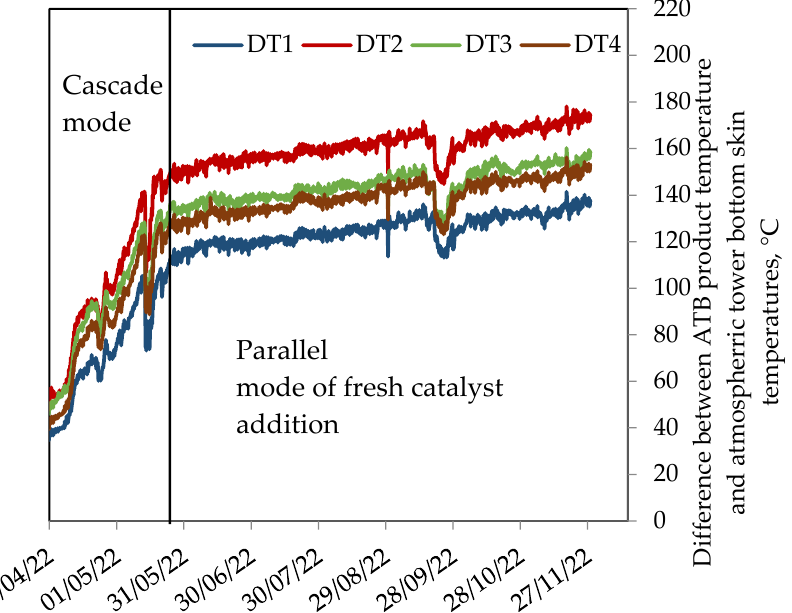
Figure 6. Variation of difference between readings between the ATB product temperature and the atmospheric tower bottom skin temperatures during the studied period (DT1; DT2, DT3, DT4 = differences between temperature of ATB product and the different ATB skin thermocouples).